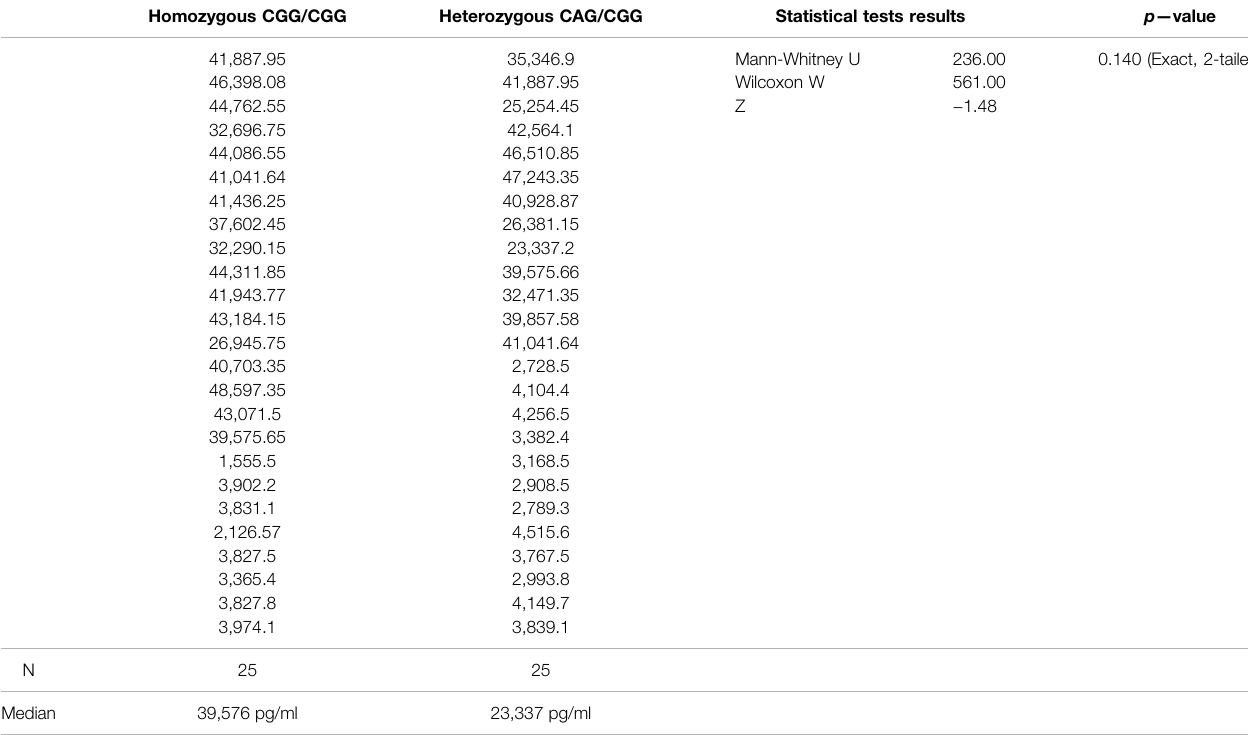
TABLE 6 | Plasma 12-HETE levels in SCD patients with different genotypes of rs1126667. Homozygous CGG/CGG